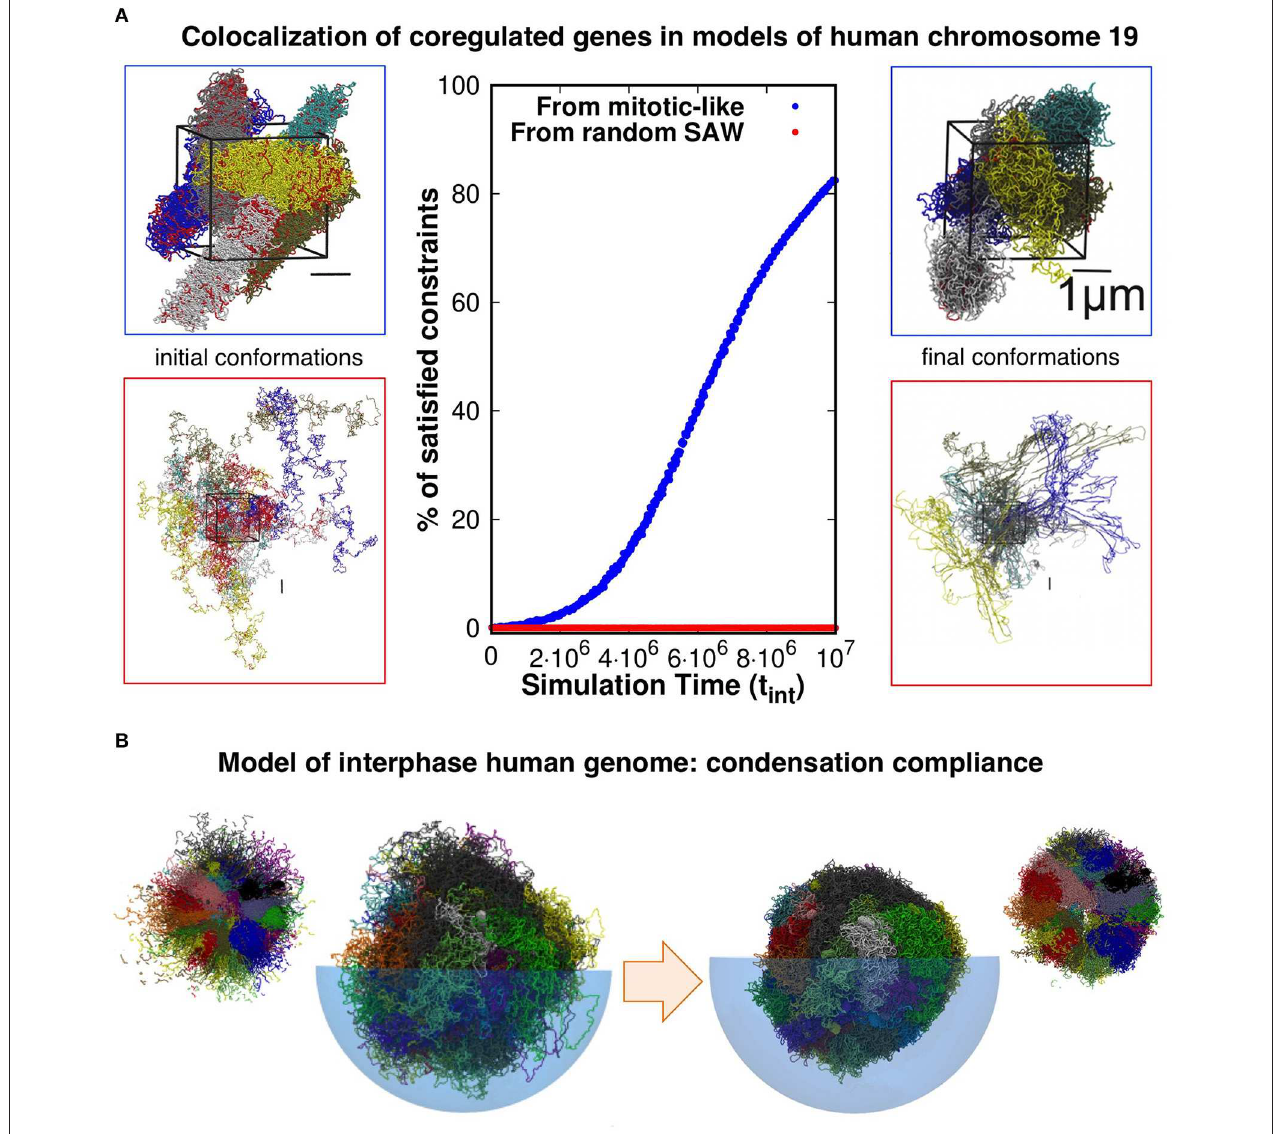
FIGURE 1 | (A) Model conformations of human chromosome 19 (six copies, arranged in a periodic simulation box), described as self-avoiding chains of beads were reshaped by steered molecular dynamics (MD) simulations to promote the colocalization of pairs of loci that are significantly coregulated. Most ( > 80 % ) of the coregulated pairs were successfully brought into spatial proximity in simulations that started from relaxed solenoidal mitotic-like arrangements, while virtually no successful colocalization was observed for trajectories started from equilibrated, fully mixed, chromosomal arrangements. Adapted with permission from Di Stefano et al. (2013). (B) Model conformations of the entire-human genome, obtained by steered-MD colocalization of loci based on Hi-C data in Dixon et al. (2012) and Rao et al. (2014) could be successfully condensed with minimal hindrance from intra- or inter-chromosomal constraints, consistently with the expected reconfiguration compliance necessary for the interphase → mitotic transition. The smaller side pictures are cut-through views. Adapted with permission from Di Stefano et al.